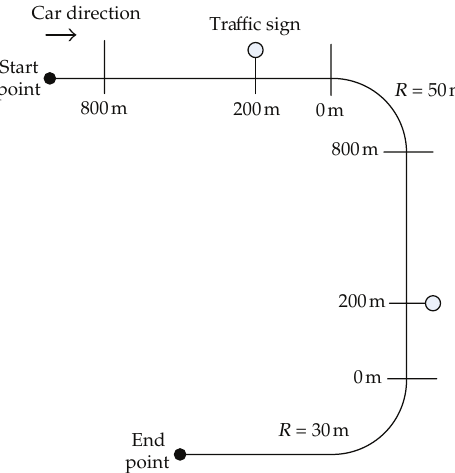
Figure 5: Five position of the traffic sign before the curves.